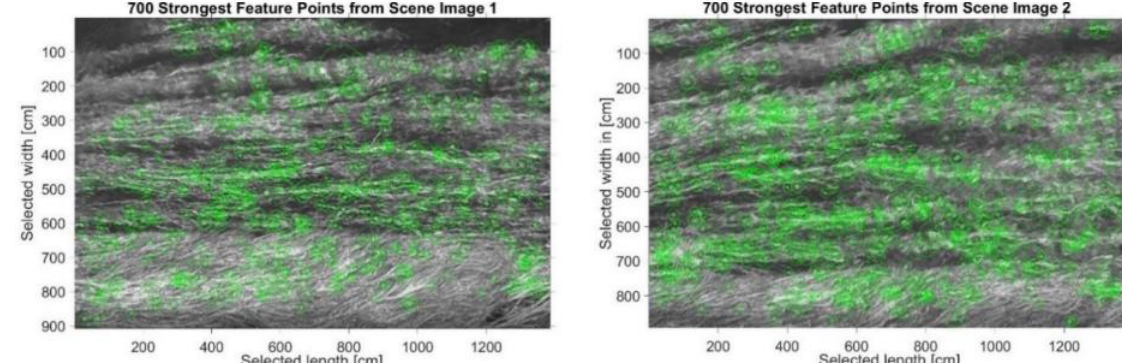
Figure 11. Detection of interesting regions of interest with major features.